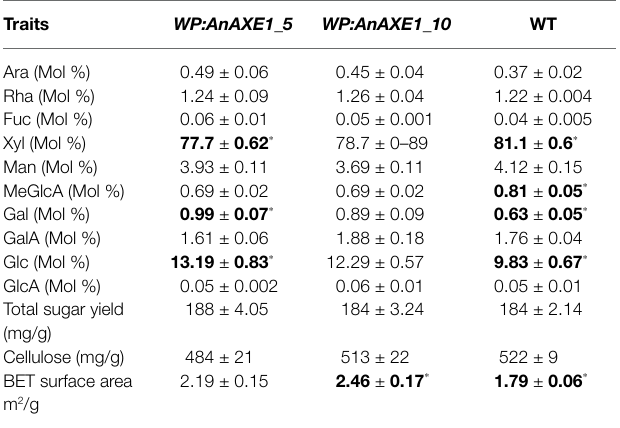
Means ± SE, N = 3. Emboldened values for transgenic lines significantly differ from WT values (Dunnett’s test, * p < 5%) and emboldened WT values significantly differ from values for both transgenic lines taken together (post-ANOVA contrast, * p <